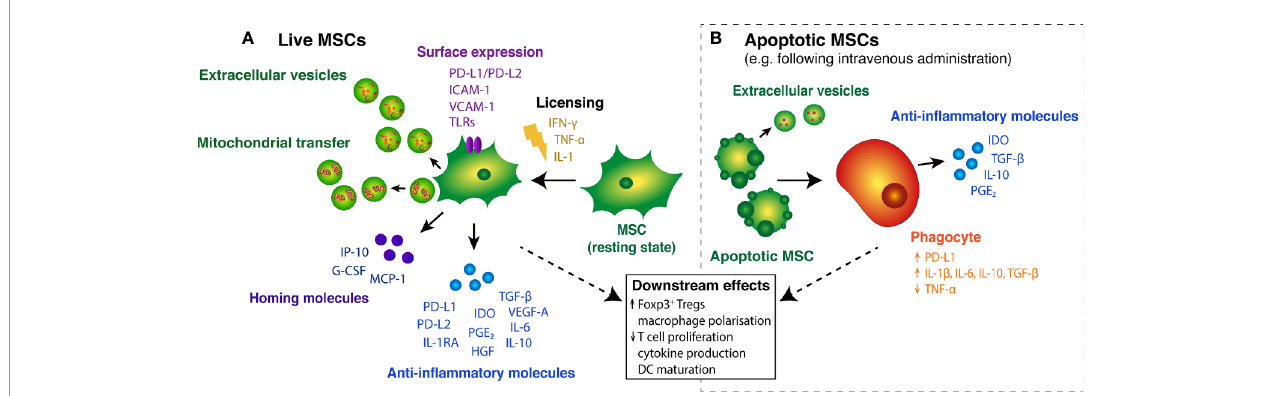
FIGURE 1 | Immunosuppressive effects of live and apoptotic MSCs. (A) In the presence of pro-in fl ammatory cytokines, resting MSCs become “ licensed ” to secrete key anti-in fl ammatory molecules, including PD-L1/PD-L2 (Davies et al., 2017), TGF- b (Niu et al., 2017) and IDO (Kim et al., 2018). Licensed MSCs also secrete homing molecules that promote MSC migration and Treg cell recruitment to tissue injury sites (Yu et al., 2011; Lunardi et al., 2014). Surface expression of various molecules on MSCs mediates interactions with T cells and guides MSC migration into in fl ammatory tissues (Ren et al., 2008; Chinnadurai et al., 2014). MSC cargo, in the form of extracellular vesicles (EVs) and subcellular components, such as mitochondria, may also play a role in MSC-mediated immunosuppression. (B) Following intravenous administration, MSCs can become apoptotic and are engulfed by circulating phagocytes, triggering the expression and release of immunomodulatory molecules (Galleu et al., 2017; de Witte et al., 2018; Cheung et al., 2019). Apoptotic cells can secrete immunosuppressive cargo packaged in extracellular vesicles (Caruso and Poon, 2018). Together, the host response elicited by live and engulfed MSCs leads to broader downstream effects on immune cell